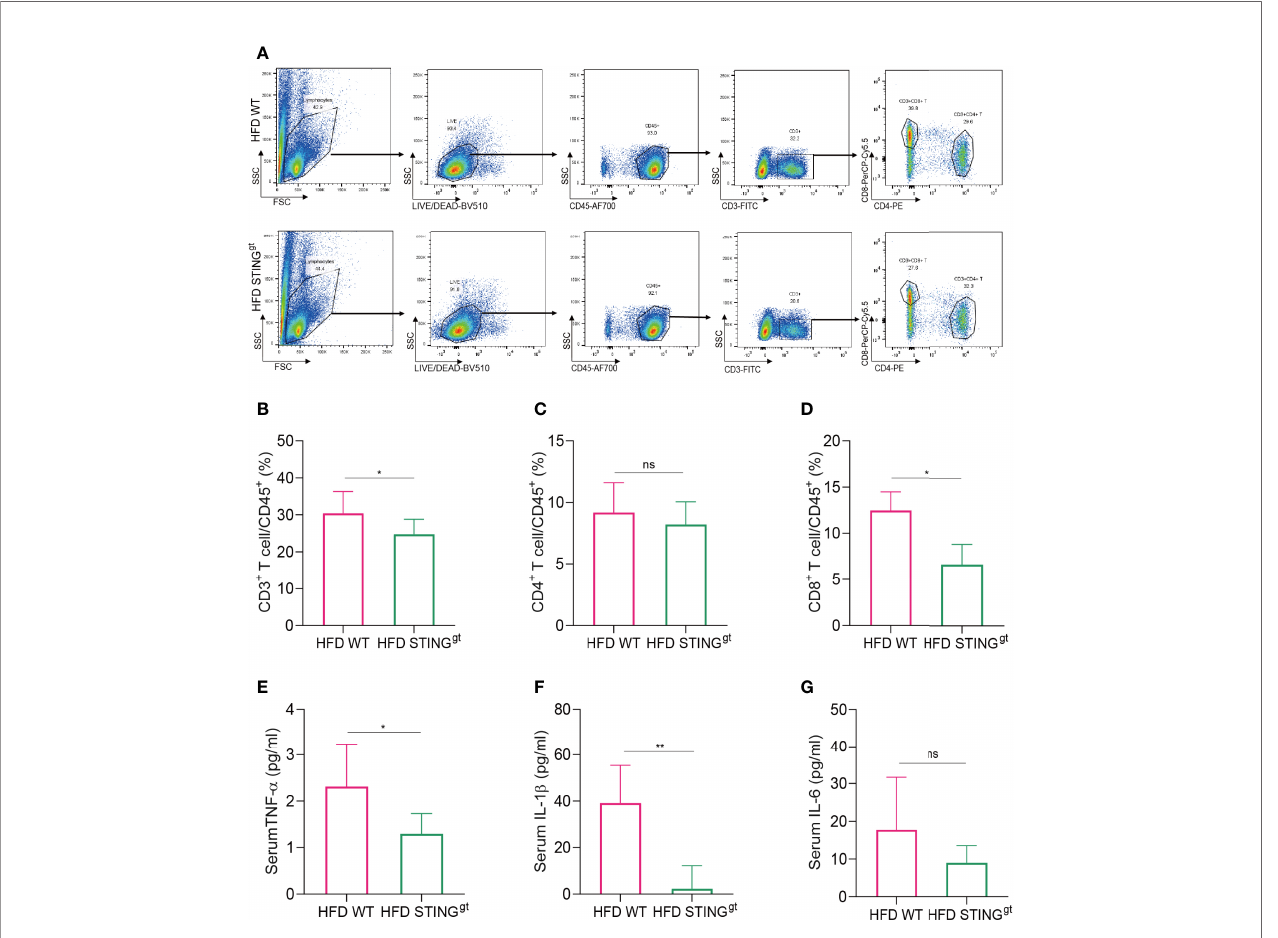
FIGURE 3 | STING de fi ciency inhibits hepatic and systemic in fl ammatory activation after HFD challenge. The liver and blood of mice were collected at 12 weeks. (A) Flow cytometry analysis of the representative histogram and antibody labeling. (B – D) The proportion of CD3 + T cells, CD4 + T cells, and CD8 + T cells in CD45 + T cells, respectively. (E – G) Serum levels of TNF- a , IL-1 b , and IL-6 were determined. ns, no signi fi cance. Data are expressed as mean ± SD, n = 6 – 8 per group. *p < 0.05, **p < 0.01 (unpaired t -test or